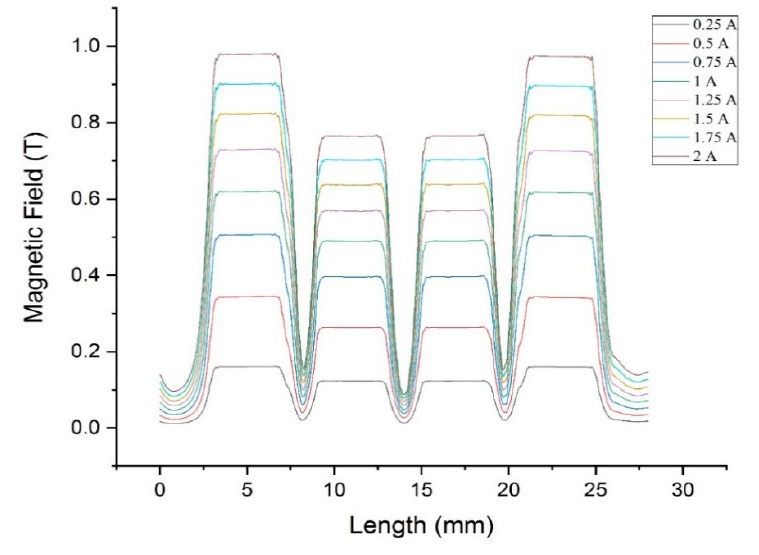
Figure 5. Distribution of magnetic field along the channel.